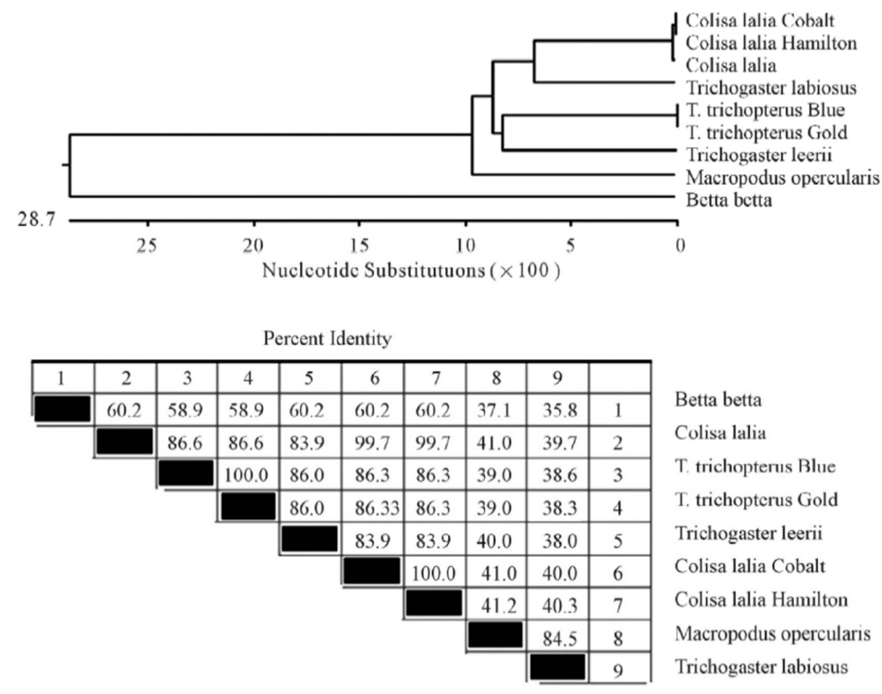
Figure 5. Composite phylogenetic tree constructed from the analysis of cytochrome b sequences of six species: T. trichopterus (blue gourami and gold gourami), T. leerii (pearl gourami), C. lalia (dwarf gourami), T. labiosus ( C. labiosa ), B. betta (fighting fish), and M. opercularis . The phylogenetic tree was constructed by Clustal W and analysis alignment methods in the MegAlign program (DNASTAR) [2]. Branch lengths represent evolutionary distances. Percent DNA sequence identities are also shown [2].